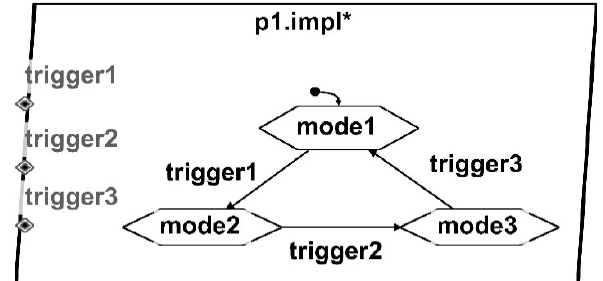
Figure 4. AADL model of an agent.